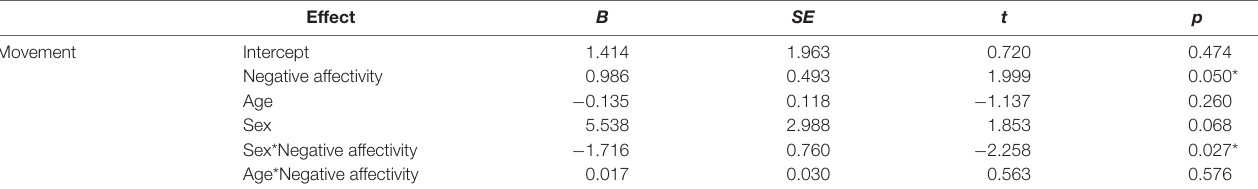
TABLE 6 | Regression results examining effects of Negative Affectivity, Age, Sex, and